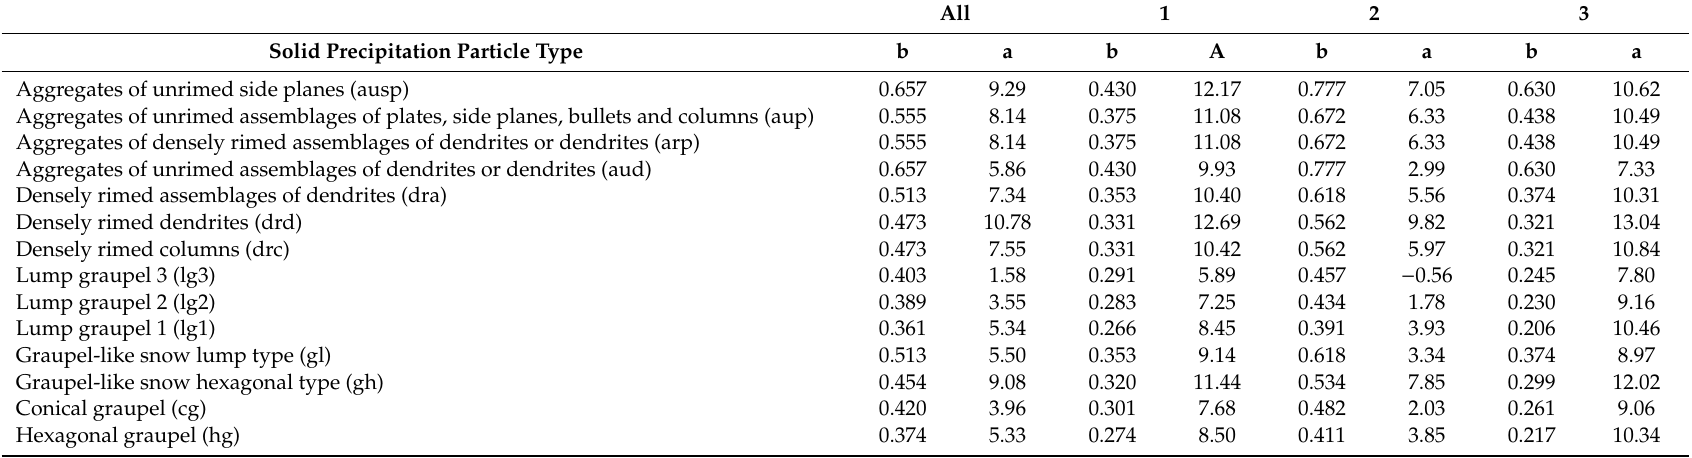
Table A1. Linear regression (parameters a, b of MRR_Ze = a + b · Parsivel_Ze and correlation coe ffi cient r) of reflectivity Ze calculated using the third lowest MRR bin (300 m) and Parsivel data using di ff erent mass-size empirical relations of crystals according to Locatelli and Hobbs [33]. Columns correspond to the whole event (All), and Stages 1, 2 and 3 (see Figure